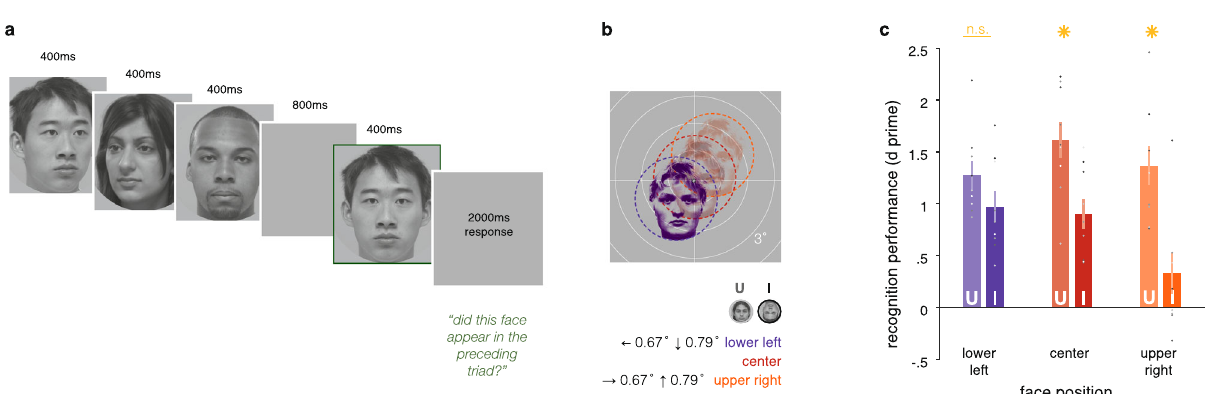
Fig. 7 The behavioral FIE is reduced at the retinotopic position that maximally overlaps mFus-faces pRF coverage. a Illustration of the trial structure and timing of the face recognition task outside the scanner. In the recognition task, participants viewed a triad of rapidly presented faces and indicated whether the subsequent target face had appeared in the triad. Within a trial, faces could be upright (as illustrated), or inverted, and appeared at the three locations described in b . Faces appeared at viewpoints ±15° around front-facing, and targets were always a different viewpoint than the triad exemplar. Subjects fi xated on a central bullseye target (0.3° diameter), and their fi xation was monitored with an eyetracker. Only trials on which participants maintained fi xation were included in analyses. b Illustration of the three positions at which faces (3.2° diameter) appeared on the screen, as determined by mFus-faces pRF coverage from the fMRI experiment (Fig. 6b). c Recognition performance averaged across participants ( N = 9) when they fi xated and viewed upright faces and inverted faces in the three locations. Recognition performance for upright faces (light color bars), was predictably highest at the center (red), and decreased when the faces were presented in the lower-left (purple) or upper-right (orange) positions. However, recognition performance for inverted faces (dark color bars) was highest at the lower-left location consistent with the neural predictions. Across participants, the behavioral FIE (upright minus inverted performance) was signi fi cantly reduced in the lower-left position, while remaining strong at the center and upper-right positions. Error bars: ±SEM across participants. Dots: individual participant performance; Asterisks: signi fi cant paired two-sided post-hoc t -test differences between upright and inverted face conditions at p < .05. N.S. not signi fi cant; t -tests followed an ANOVA, see text. U: upright faces, I: inverted